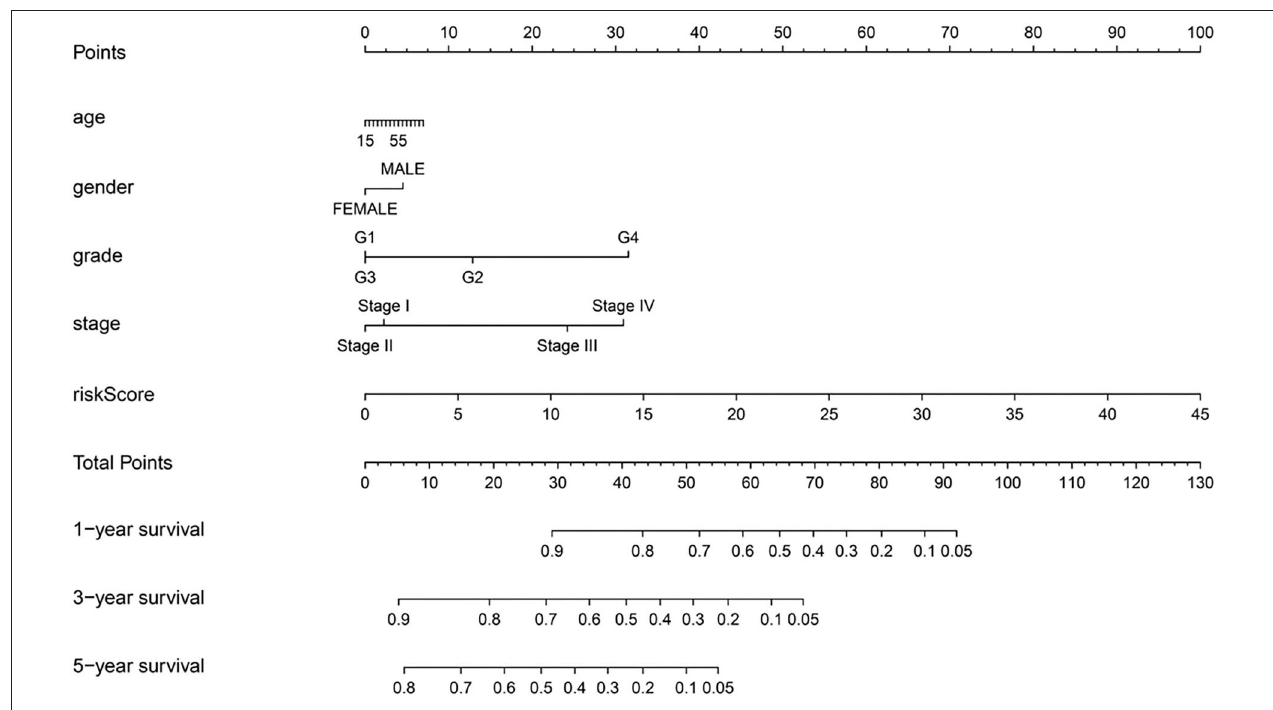
FIGURE 7 | A predictive nomogram for OS in the training group.